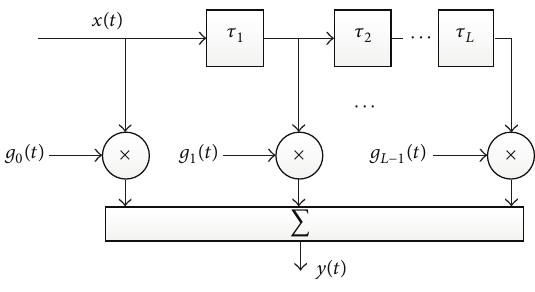
Figure 1: TDL based